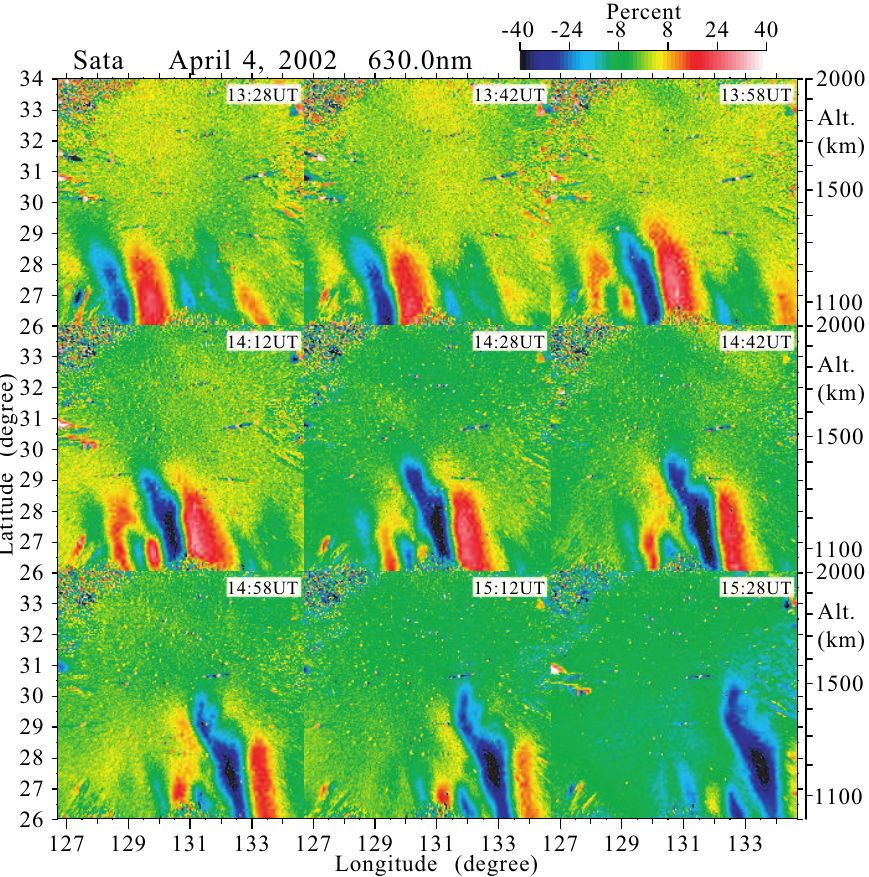
Fig. 4. Evolution of the plasma bubble structure seen in the 630.0-nm airglow images at Sata, Japan, at 13:28–15:28 UT (22:28–00:28 LT) on 4 April 2002, in the same format as that in Fig.